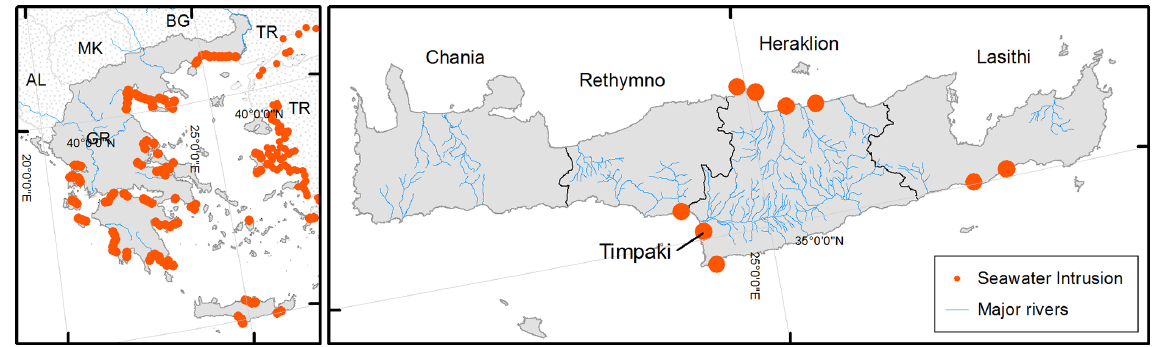
Figure 1. Areas of seawater intrusion in Greece (left) and specifically in Crete (right). Adopted from Daskalaki and Voudouris (2008) and EEA